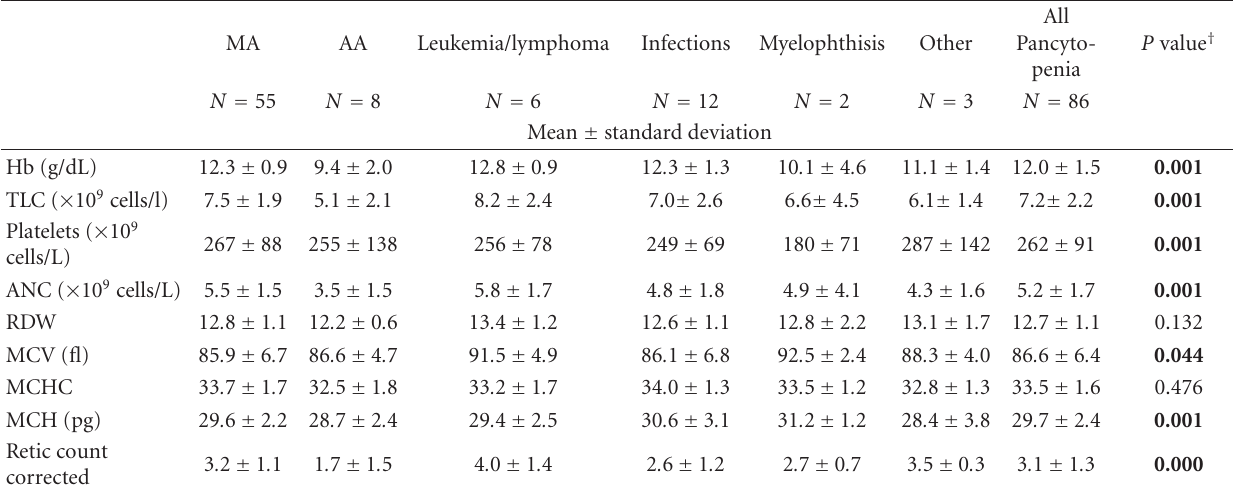
Table 4: Hematological parameters of patients at follow